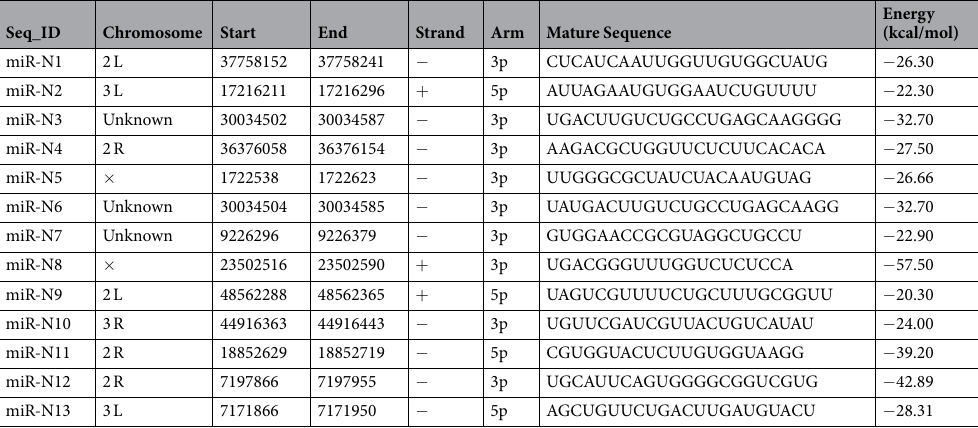
Table 1. Novel miRNAs in An . gambiae